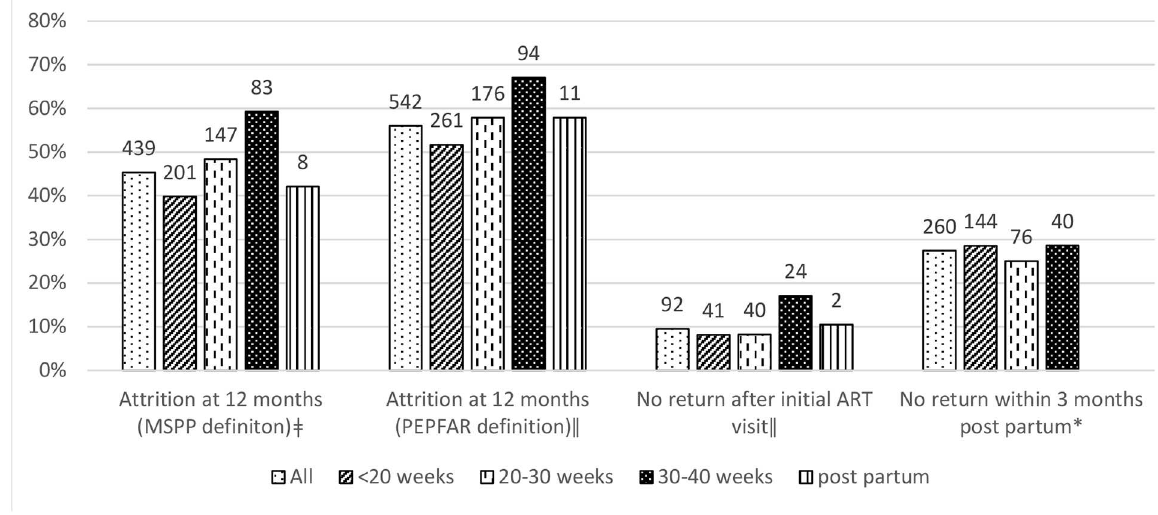
Fig 2. ART attrition indicators by gestational age at ART start. ** Among 968 Option B+ patients with availabledata on pregnancy dates. ǂ p < 0.001 ǁ p = 0.01 * p = 0.54 for Chi2 test of equality of proportions across gestationalage